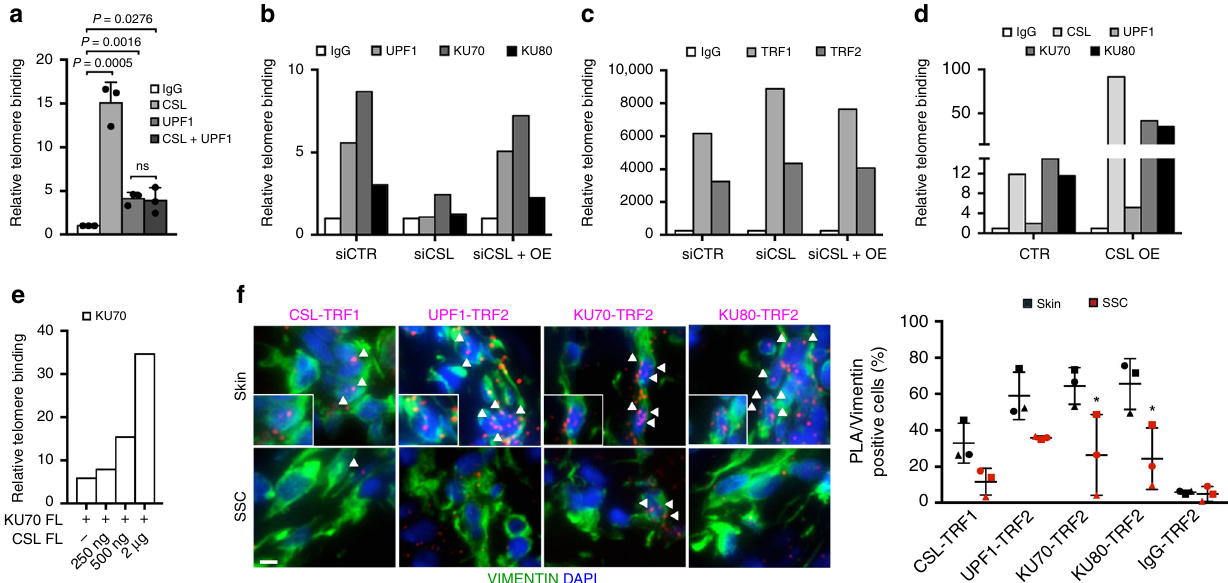
Fig. 7 UPF1/Ku70/Ku80 recruitment to telomeres is impaired by CSL loss. a Telomere binding assay by ChIP/qPCR with antibodies against CSL and UPF1, individually or sequentially (CSL + UPF1), in parallel with non-immune IgG, in HDFs as in 34,35 . n (strain) = 3, * p < 0.05, two-tailed unpaired t -test. b Telomere binding assays by ChIP/qPCR with antibodies against the indicated proteins in HDFs (GB1) plus/minus siRNA-mediated CSL silencing (3 days) or CSL silencing and concomitant lentivirally induced CSL overexpression (OE). Similar experiments with two additional HDF strains (GB3 and GB4) are in Supplementary Fig. 8b. c Telomere binding assays by ChIP/qPCR analysis of the same cells as in b with antibodies against TRF1/TRF2. Similar experiments with two additional HDF strains (GB3 and GB4) are in Supplementary Fig. 8c. d Telomere binding assays by ChIP/qPCR with antibodies against the indicated proteins in HDFs (GB1) plus/minus lentivirally induced CSL overexpression (OE) for 3 days. Similar experiments with two additional HDF strains (GB3 and GB4) are in Supplementary Fig. 8d. e Telomere binding assays by ChIP/qPCR with anti FLAG-tag antibodies in HEK293T cells expressing increasing amounts (0, 250 ng, 500 ng, and 2 μ g) of FLAG-tagged full length (FL) CSL together with full length (FL) Ku70 (2 μ g). Non-immune IgGs were used for normalization. A second independent experiment is in Supplementary Fig. 8e. f PLAs of stromal fi broblasts (identi fi ed by VIMENTIN staining) from unaffected skin versus fl anking SCC with TRF1 or TRF2 antibodies in combination with antibodies against the other indicated proteins. Scale bar, 5 μ m. Quanti fi cation of CSL and UPF1/Ku70/Ku80/TRF1/TRF2 levels in the same samples are in Fig. 2b and Supplementary Fig. 8f, respectively. Triangles, circles, and squares point to values from fl anking skin (black) and corresponding SCC (red) from three patients. Non-immune IgGs were used as control. Mean± SD, n (cells) > 77 per condition, n (SCC) = 3, n (matched Skin) = 3, * p < 0.05, two-tailed paired t -test. Bars represent mean ±